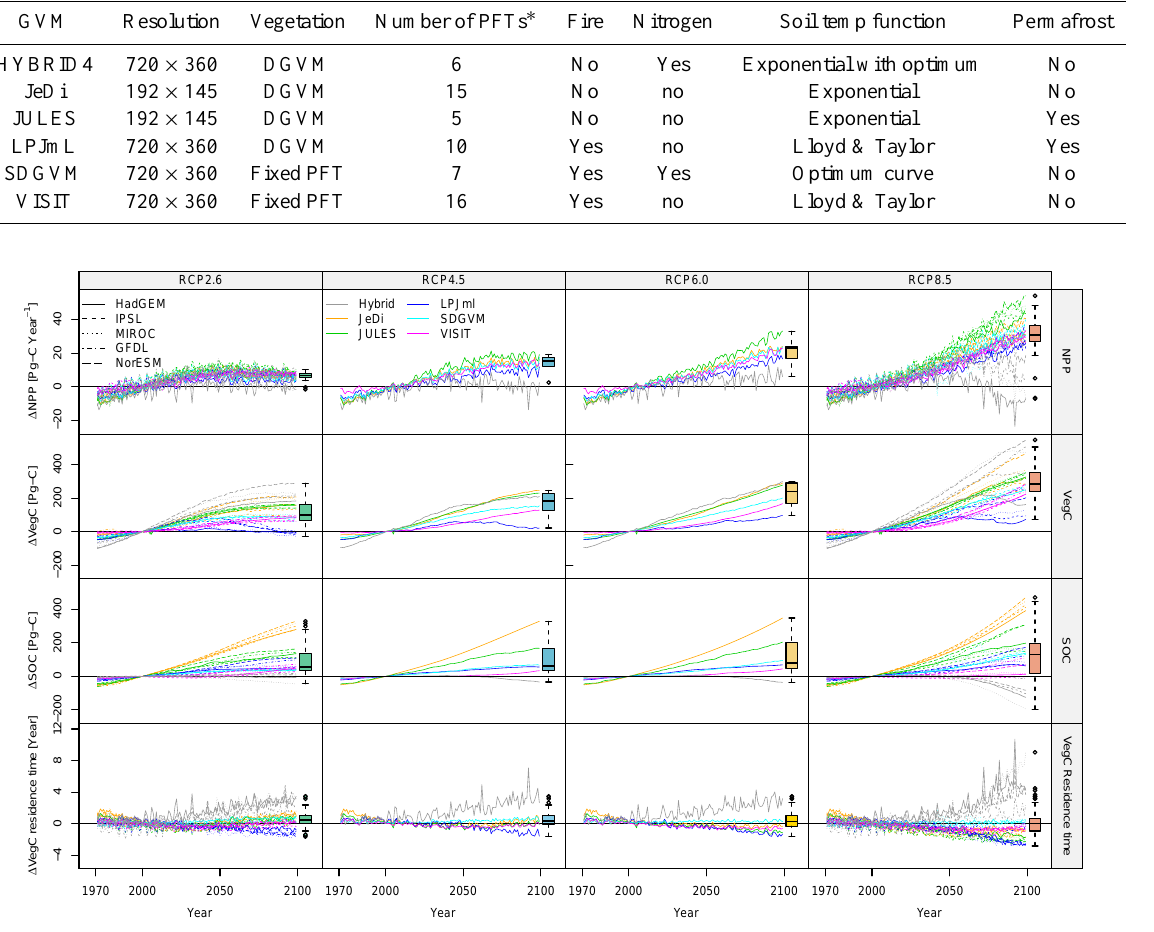
Figure 1. Global annual NPP, VegC stock, SOC stock, and VegC residence time changes. The boxplot summarizes the values at the end of the simulation period. Open circles represent outliers if the largest (or smallest) value is greater (or less) than 1.5 times the box length from the 75% percentile (or 25%